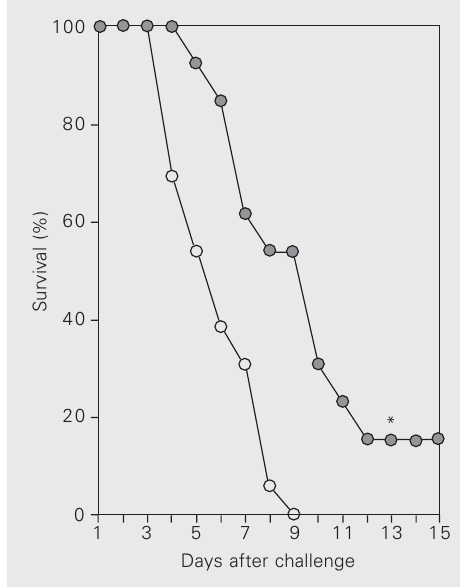
1. Survival of Escherichia coli EMO strain in infected gno- tobiotic mice orally challenged with Salmonella Typhimurium. Germ-free mice received PBS orally (control, open circles) or E. coli EMO strain (experimen- tal, filled circles) 10 days before challenge. The figure illustrates one representative experiment of two, with similar results, us- ing 6 mice per group and per experiment. *P < 0.05 com- pared to control (Student t